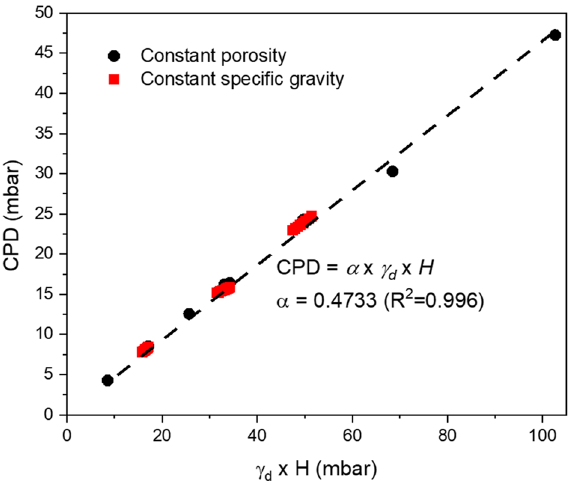
Figure 3. CPD versus overburden pressure at the bottom of the bed (γ d · H ). γ d is the dry unit weight of soil, and H is the height of the simulant bed.